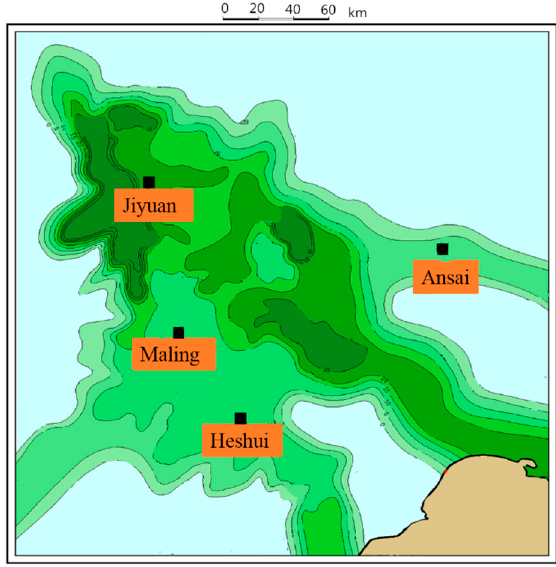
Figure 5. Locations of the four pilot areas in Chang 7 reservoir.